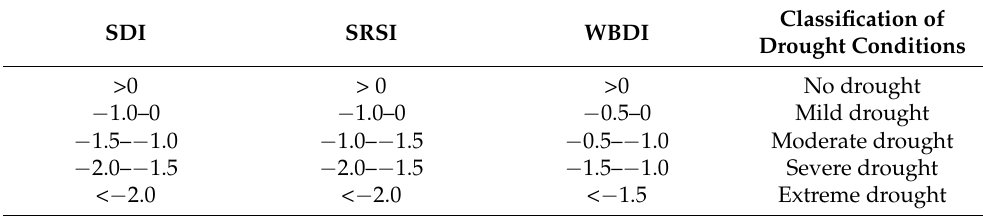
Table 4. Classification of drought conditions according to SDI, SRSI, and WBDI ranges. SDI SRSI WBDI